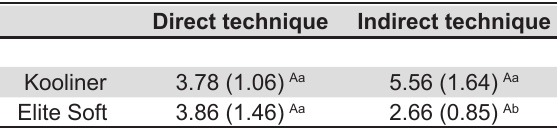
Table 1- Knoop hardness means (standard deviation) of Kooliner according to the techniques and times (before and after thermal cycling)